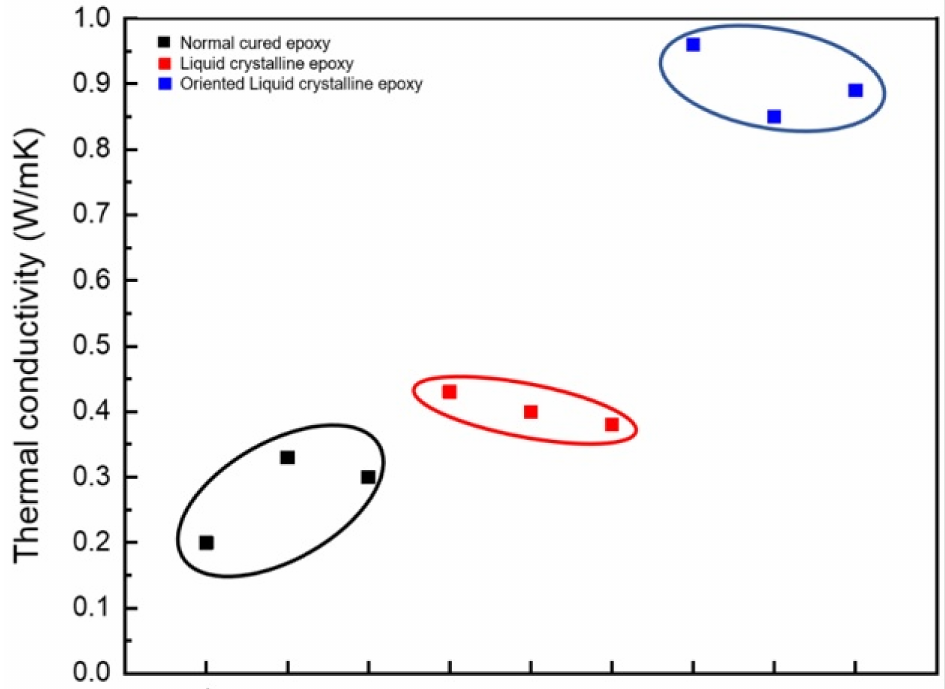
Figure 14. Distribution of thermal conductivity with 10 types of cured epoxy